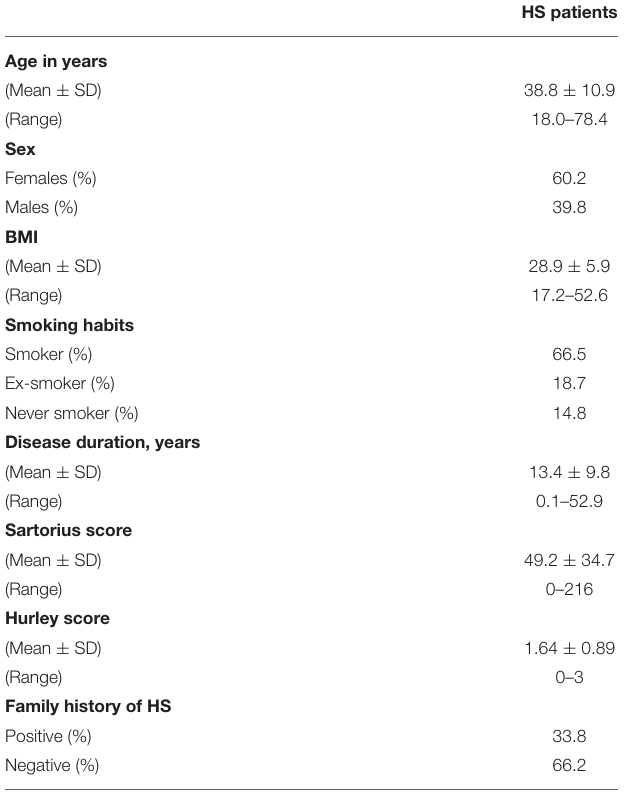
TABLE 1 | Demographic and clinical characteristics of the study cohort ( n = 462).